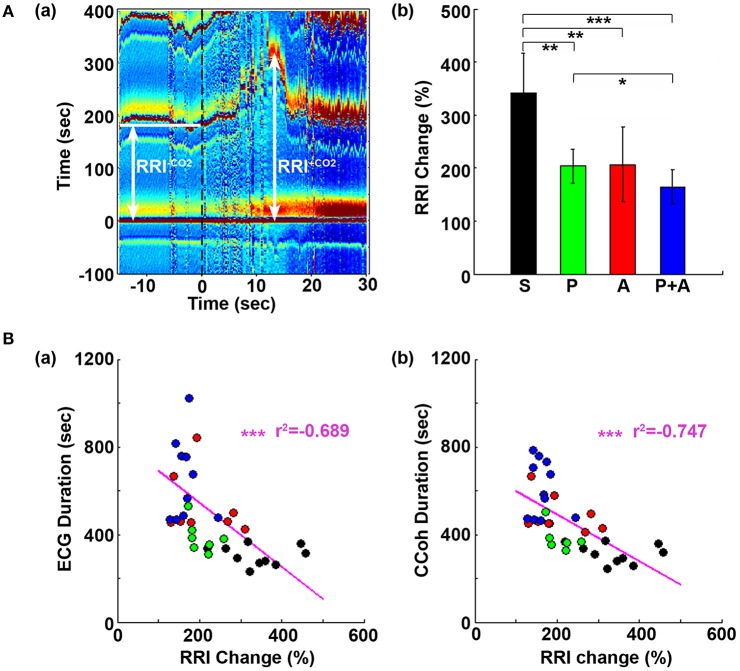
Adrenergic blockade suppresses the initial rise of RR interval (RRI), which negatively correlates with cardiac survival and cortical coherence (CCoh) duration. (A) Electrocardiomatrix (ECM) display of ECG signals −15 s before and 30 s after asphyxia for one control rat (a). RRI−CO2 represents the averaged baseline RRI (100 s before asphyxia); RRI+CO2 indicates the peak amplitude of the first increase of RRI after asphyxia. The mean and SD of RRI change (RRI+CO2 × 100/RRI−CO2) shows drug-specific changes (b). Significant differences of RRI among the rats are indicated using asterisks. Error bars denote SD (*p < 0.05, **p < 0.01, ***p < 0.001). (B) RRI changes are correlated with the survival times of both the heart (a) and the brain (b). Each circle represents data from one rat. Linear regression lines were plotted to show the correlation between RRI change and ECG duration (a), and between RRI change and CCoh duration (b) for all four groups of rats. Significant correlations between RRI change and ECG duration, or between RRI change and CCoh duration are indicated using asterisks (*p < 0.05, **p < 0.01, ***p < 0.001).